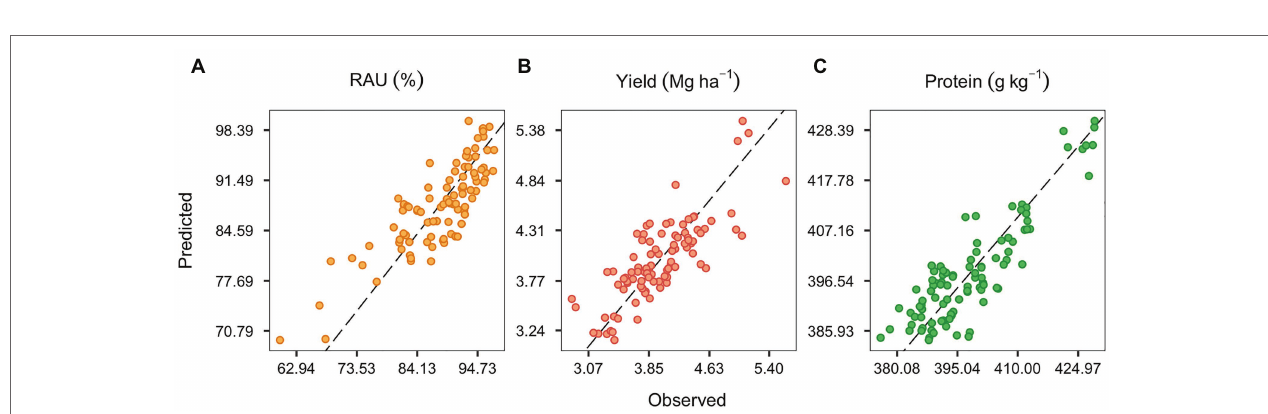
FIGURE 2 | Predicted and observed data for the relative abundance of ureides (RAU; A ), seed yield (B) , and seed protein concentration (C) . Elastic net regression model considering all the environment, crop, and management covariables (full